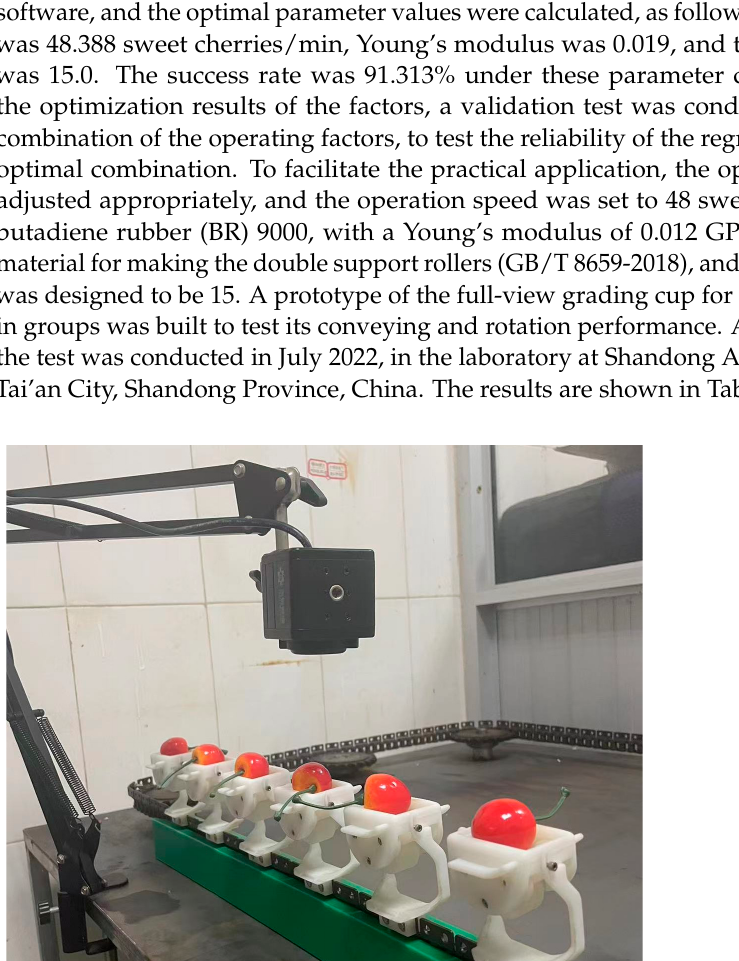
Figure 15. Performance test for the full-view-type grading cups.